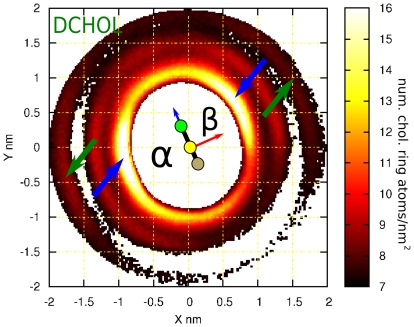
In-plane distribution of lipids and Dchol around Dchol in DSPC bilayer with 20 mol% Dchol.The two-dimensional average density distribution for Dchol molecules around a tagged Dchol. This corresponds to the density distribution of atoms in the ring of the Dchol molecules (15 atoms per Dchol molecule). The data presented corresponds to a DSPC bilayer with 20 mol% Dchol. A schematic representation of the tagged Dchol is shown at the center. As Dchol does not possess out-of-plane methyl groups, it is represented by a simple rod. As the presence of C18 is required to define the axes (see Figure 1), the missing methyl groups in Dchol molecule were reconstructed assuming tetrahedral geometry and thus α- and β- faces can be recognized. A comparison between the two sides of Dchol shows that their behavior is similar to behavior of the smooth Chol face. Similar to the behavior of Chol, no Dchol is seen in the first coordination sphere. On each side of the second coordination shell a peak facing the rod is observed (marked with blue arrows). Some structure is still present in the outer coordination shell (∼1.8 nm) displaying peaks collinear with the previous ones (green arrows). This reflects a strong preference to form linear Dchol-Dchol structures.